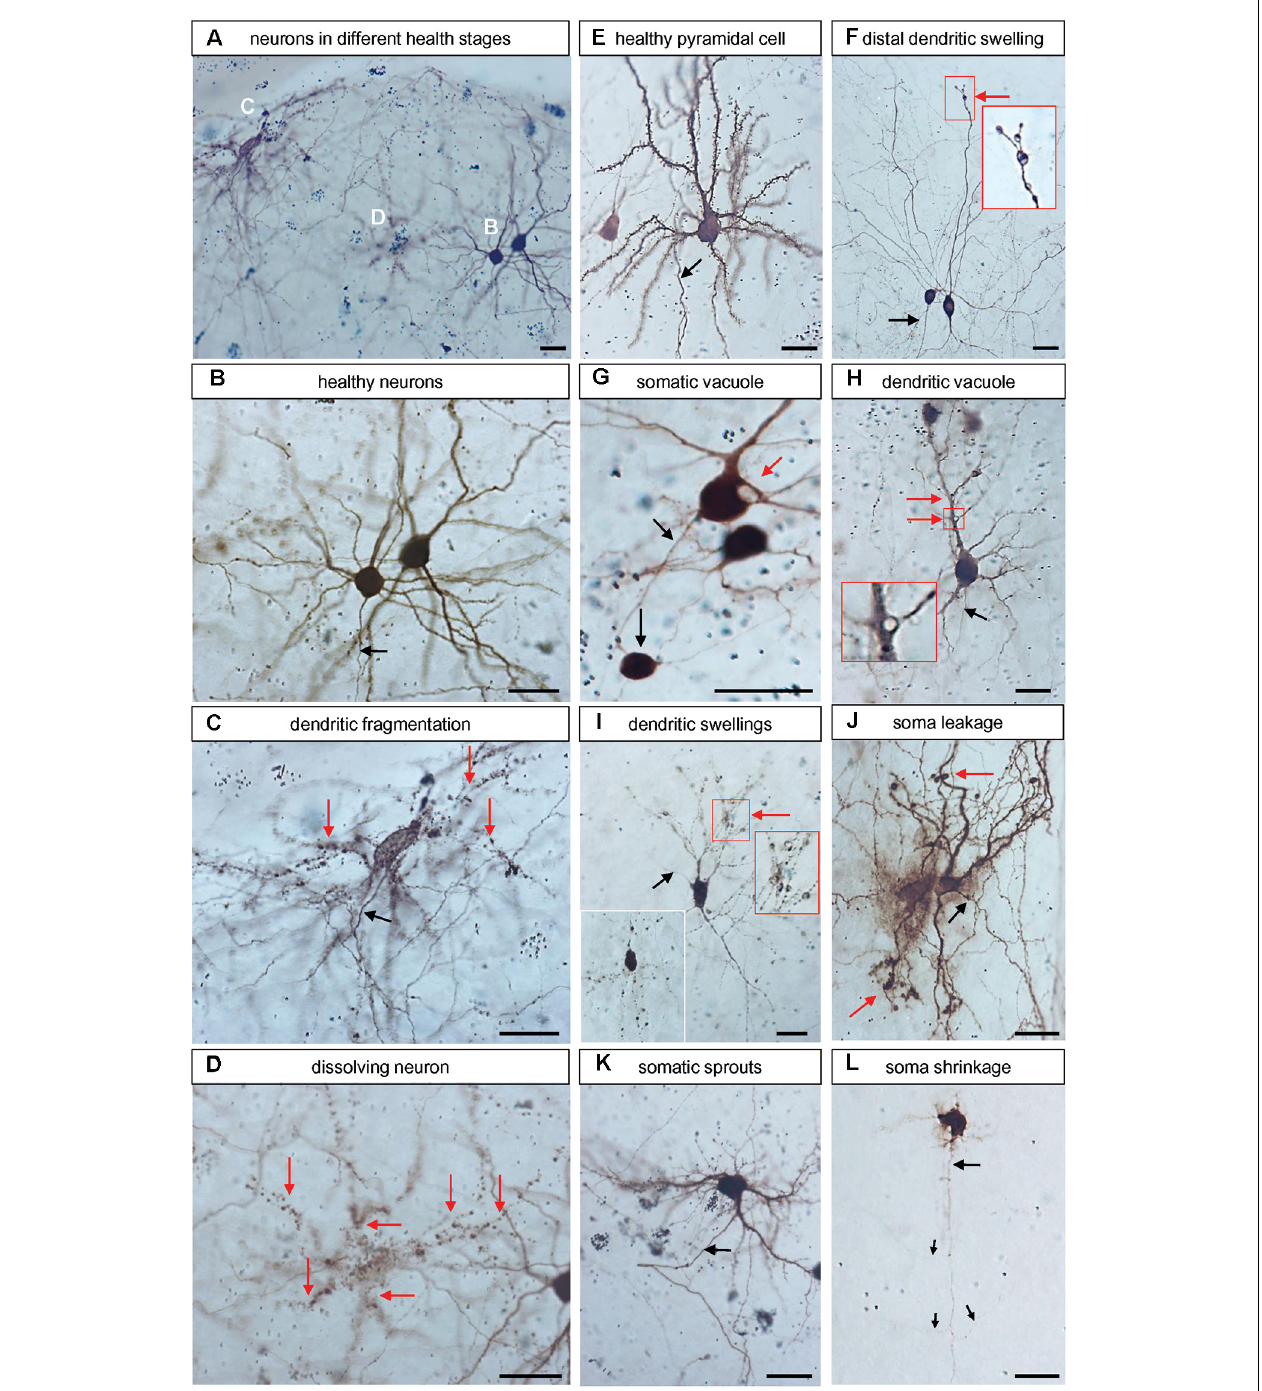
FIGURE 1 | Representative examples of neurons with symptoms of degeneration. All microphotographs were taken from DIV 25 control with peroxidase immunostaining against EGFP. (A) Overview of four neurons in different stages of degeneration shown at higher magnification in (B–D) below. (B) Two healthy neurons, the axon is descending (arrow). (C) A neuron with dendrites breaking up into “rows of dots” (red arrows); note that the axon (black arrow) looks entirely healthy. (D) A cell in the final stage of dissolution; the argument that this has been a neuron derives from the observation that the rows of dots demarcate about six former dendritic trees (red arrows). (E) Healthy pyramidal neuron studded with spines and descending axons (arrow). (F) Two interneurons, one had distal dendritic swellings (red arrow, the boxed area is enlarged in the inset). (G) Neurons with a large somatic vacuole and a gigantic swelling at the axon’s first branch point which resembles a neuroma. (H) Quite healthy-looking pyramidal neuron with vacuoles at dendritic branch points (red arrow, boxed area enlarged). (I) A degenerating neuron with many swellings along the dendritic trees (red arrow, the boxed area is enlarged in the inset). A second inset at the lower left depicts other neurons where the dendrites are broken down into